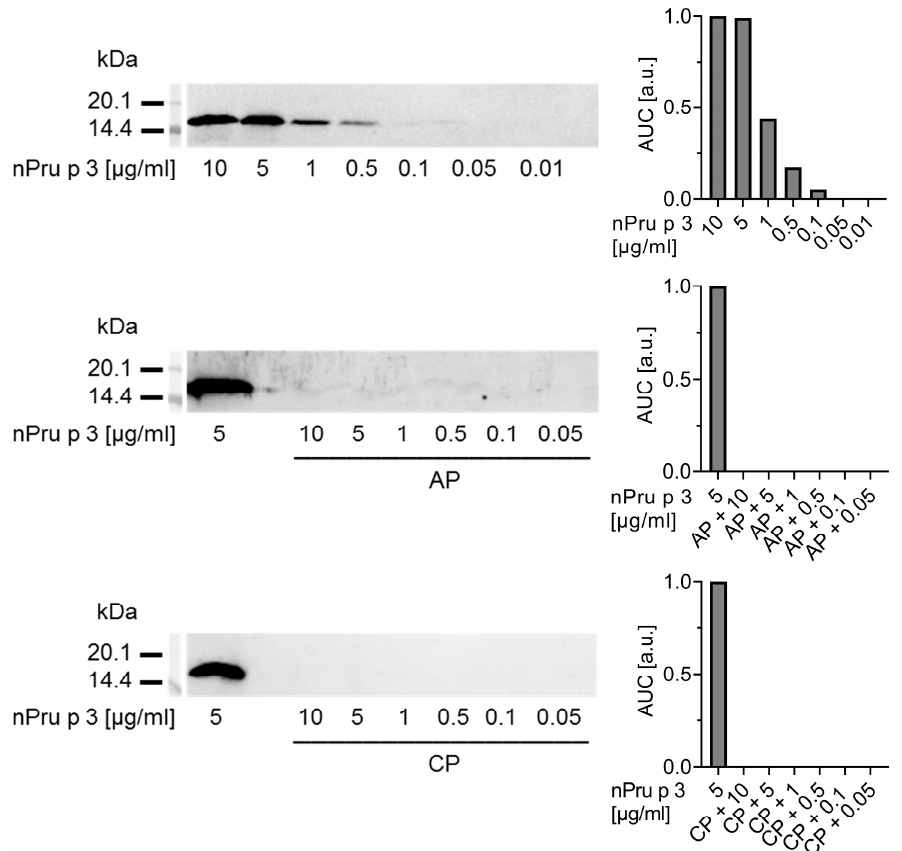
Figure 3. Detectability of peach nsLTP Pru p 3 in 10% pectin (apple-derived pectin (AP) and citrus- derived pectin (CP)) matrix was evaluated via immunoblotting using a cross-reactive nsLTP rabbit antiserum. The protein detectability was semi-quantified using the area under the curve (AUC) normalized to blank. Decreasing concentrations of nPru p 3 (10–0.01 µ g/mL) and nPru p 3 dose-dependently spiked in 10% pectin were analyzed. Again, twice the value of the blank control was